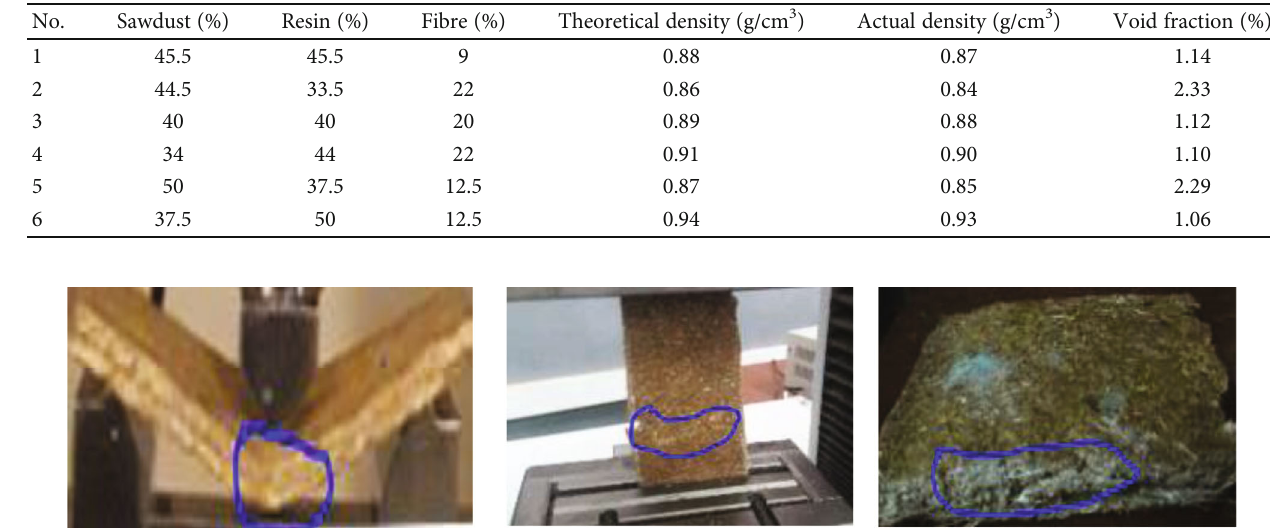
Table 6: Density and void fraction of the composite material with di ff erent proportions.